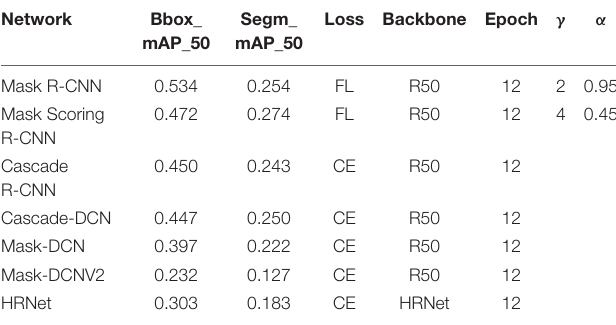
TABLE 8 | Results of the method proposed in this study compared to other